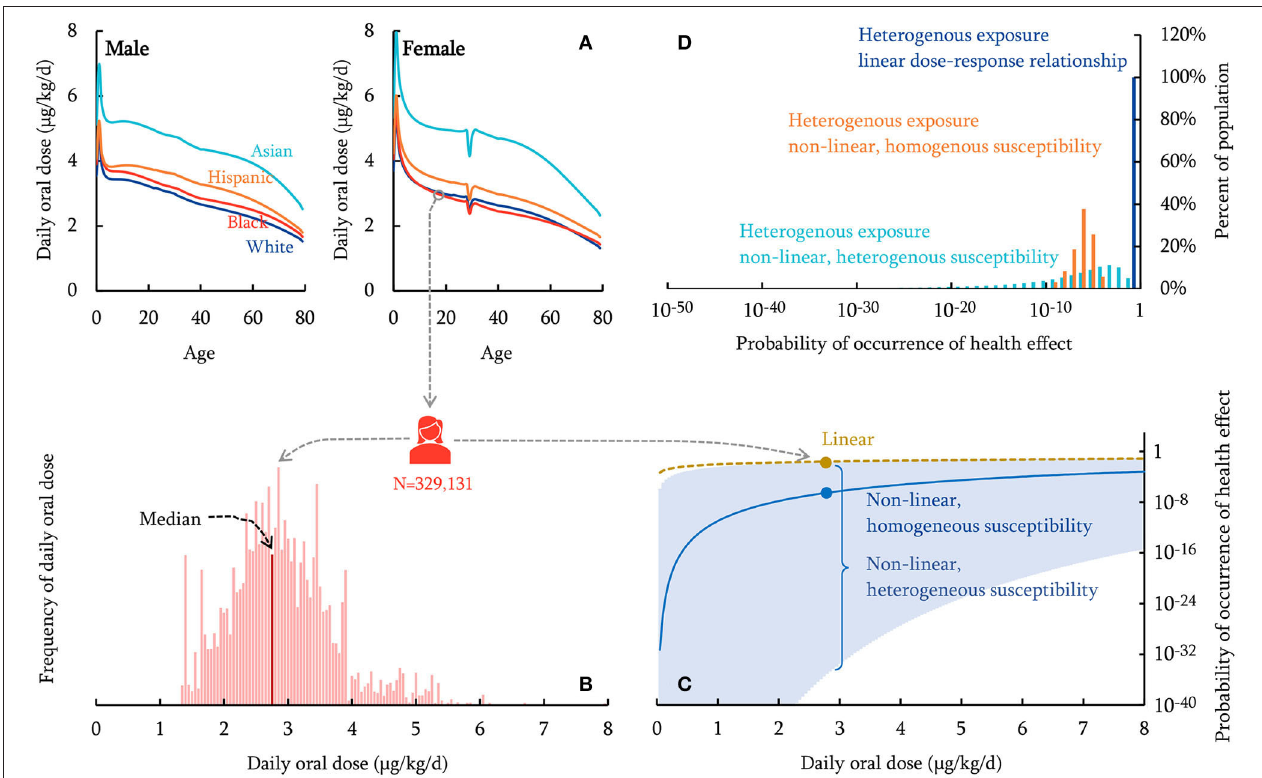
FIGURE 1 | Schematic overview of the human health characterization approach (dieldrin for illustration). The PROTEX model predicts daily oral dose of chemicals with variabilities in age, sex, race/ethnicity (A) . A nationally representative population of 329,131 virtual individuals is generated, each of which is assigned a daily oral dose sampled from the PROTEX predictions based on the individual’s age, sex, race/ethnicity (B ; the population median is indicated ) . The probability of occurrence of health effects is calculated for each virtual individual, based on dose-response relationships that are linear (dashed curve), non-linear with homogeneous susceptibility across the population (solid curve), or non-linear with individual-specific heterogeneous susceptibility (95% Confidence Interval shown in shadow) (C ; Probability of occurrence of health effects on a logarithmic scale ) . (D) shows the distribution of the calculated probability of occurrence of health effects within the virtual